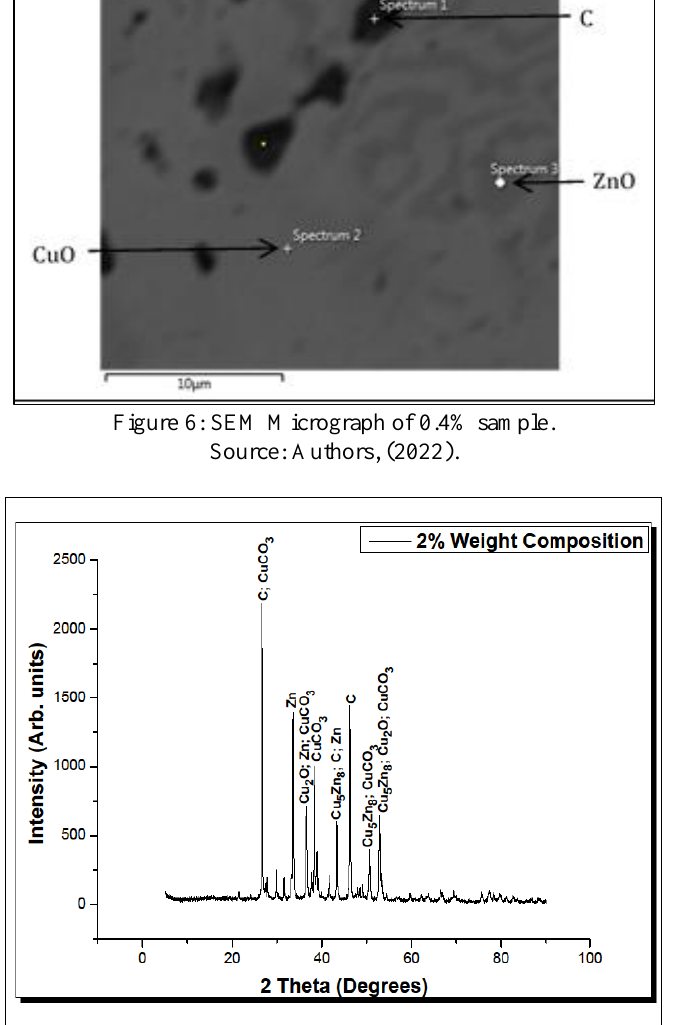
Figure 7: XRD of 2% sample. Source: Authors, (2022).